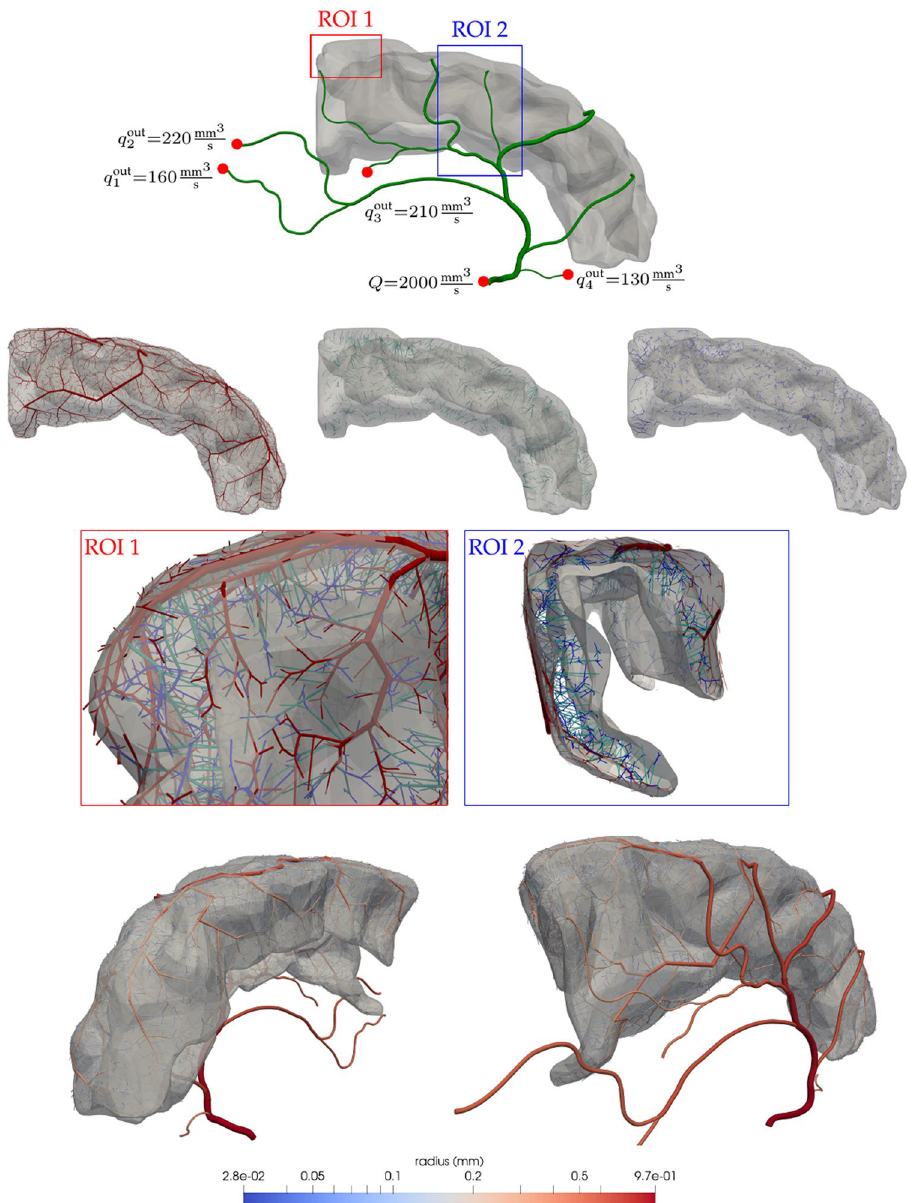
Figure 7. Grey matter vasculature in the superior frontal gyrus generated by a four-staged growth process: (first row) initial tree T 0 , illustrating the inflow and outflow constraints; (second row) from left to right, vessels corresponding to the pial network ( T 1 ∪ T 2 ), penetrating arterioles ( T 3 ) and deep arterioles ( T 4 ); (third row) superior-posterior part (left) and coronal slice at a middle section of the rostral-caudal axis (right), describing the architectural organisation of pial (red), penetrating (green) and deep (blue) vessels across the tissue; and (fourth row) final vascular tree depicting the vessel radius. Images generated with ParaView version 5.4 available at https ://www.parav